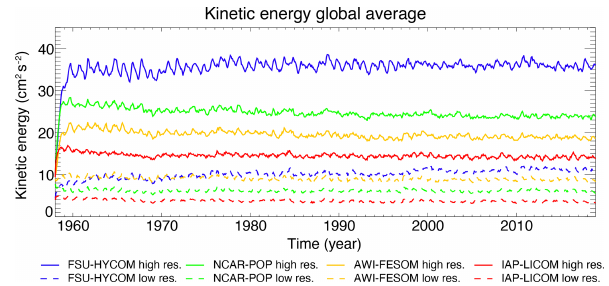
Figure 2. Time evolution of the domain-averaged kinetic energy (10 − 4 m 2 s − 2 ) for all